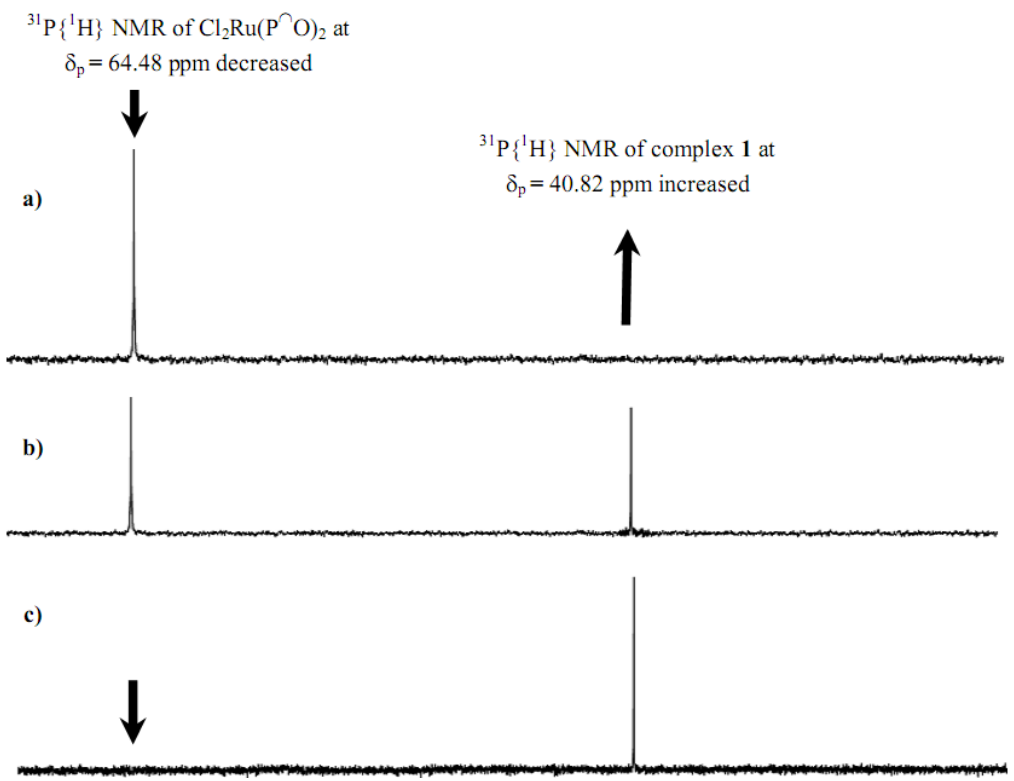
Figure 1. Time-dependent 31 P{ 1 H}-NMR spectroscopic of Cl mixed with two equivalent of 3-(triethoxysilyl)propylamine co-ligand in CDCl NMR tube to produce complex 1 at δ and c) 2 min. after the co-ligand